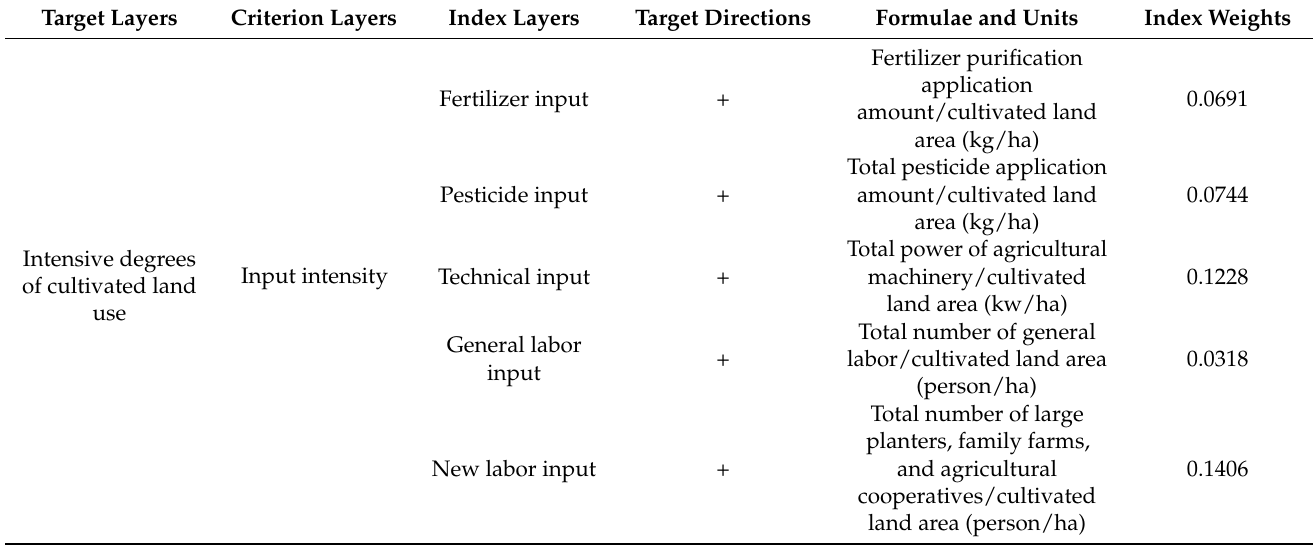
Table 1. Indicator system of cultivated land use